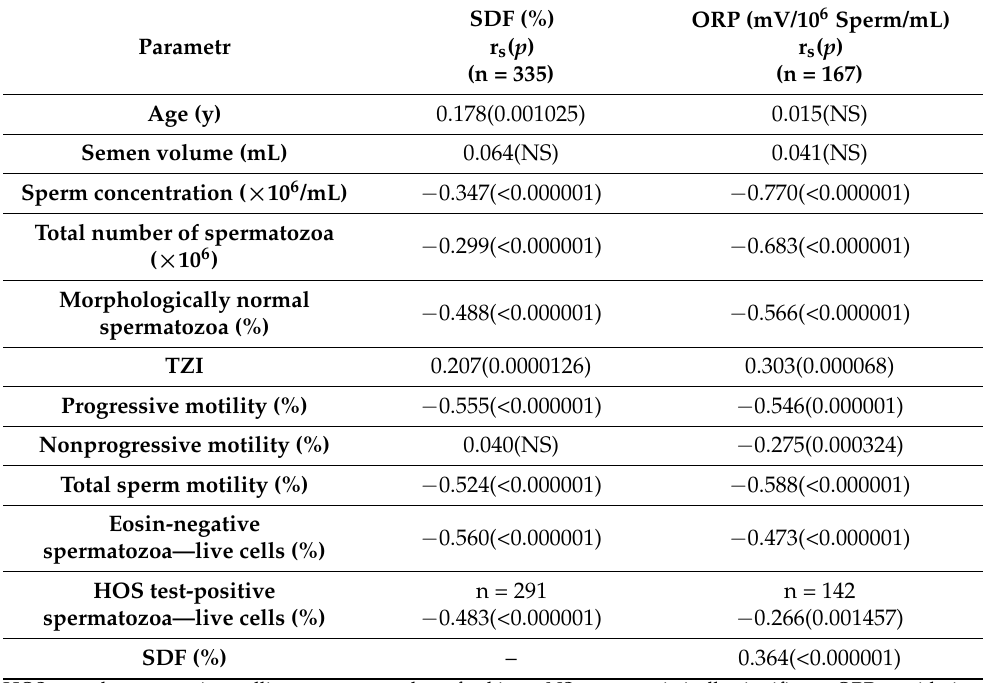
Table 6. Rank Spearman correlation (r s ) between SDF, ORP, male age and standard semen parameters in the total